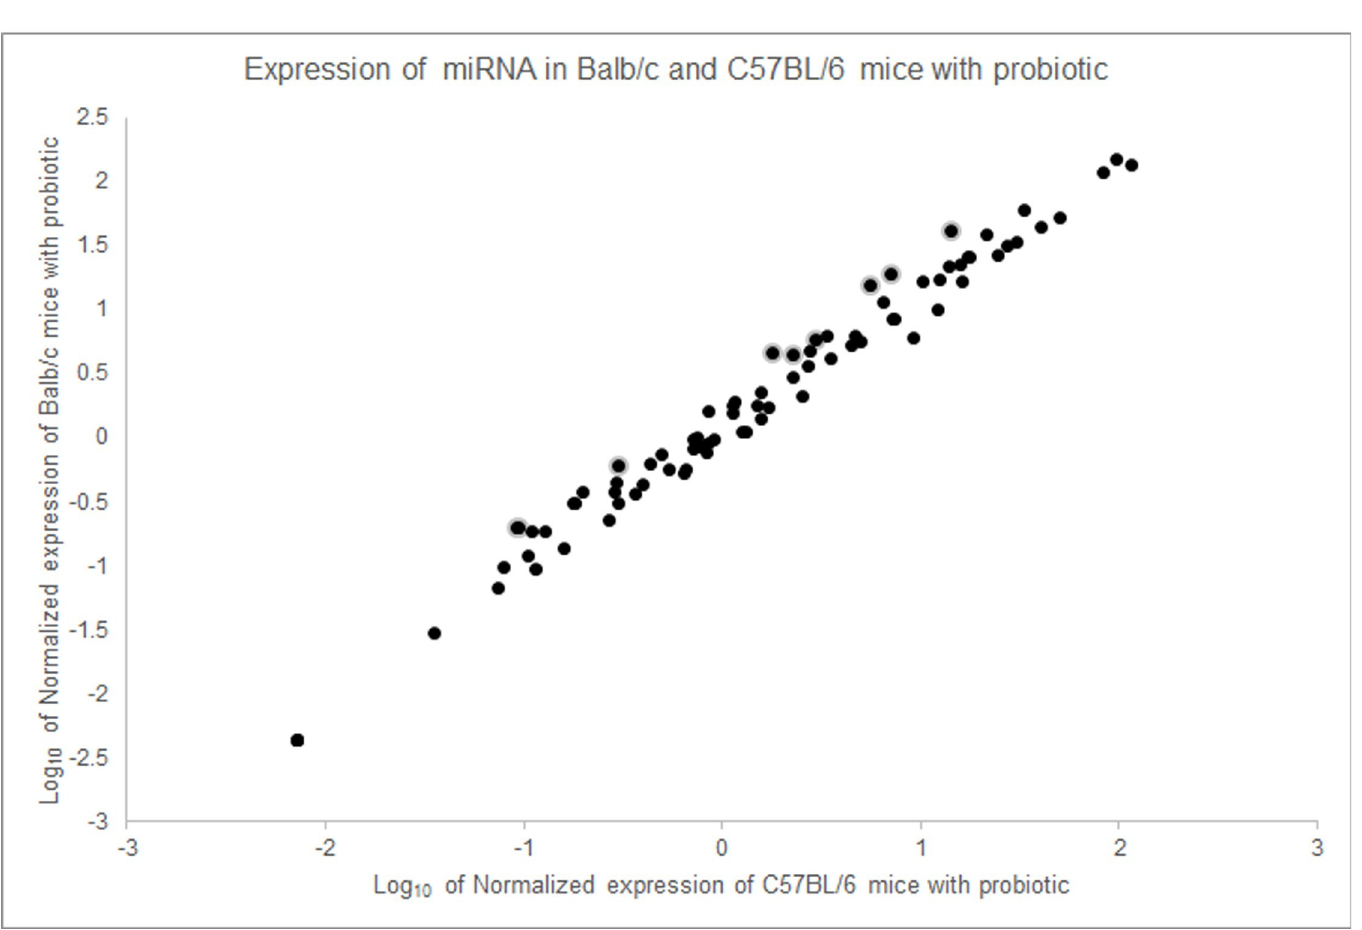
Fig 3. Expression of miRNA in the brains of mice with B . longum treatment. Expression of brain miRNAs were measured using a PCR array screening of miRNAs associated with neurological development and health. Without treatment, some miRNAs, including mmu-mir-652-3p, are expressed differently in Balb/c and C57BL/6 mice (see Fig 1). With treatment, expression of most miRNAs tested align between the two strains of mice.